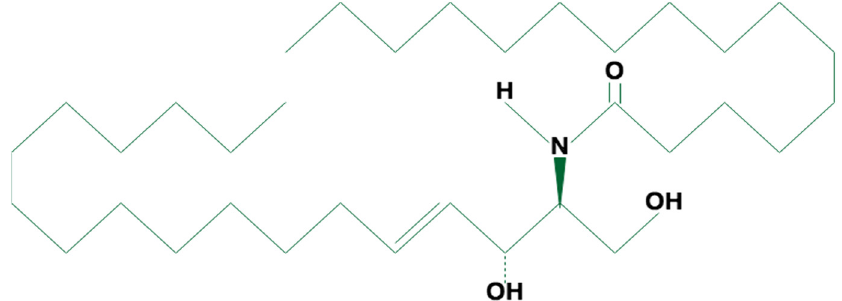
Figure 1. Structure of the C16 Ceramide (d18:1/16:0), created with